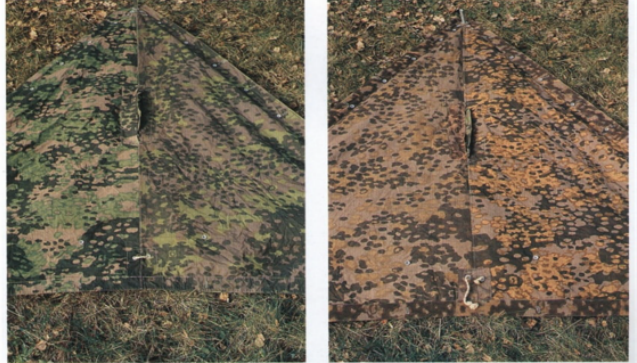
Figure 3. Example of Zeltbahn mimetic camouflage in spring ( left ) and autumn ( right ) versions [8].